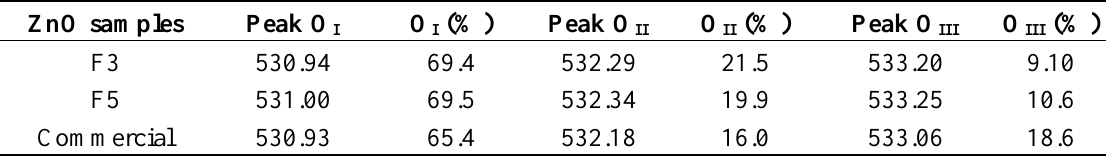
Table 2. Comparison of O1s XPS data for different ZnO